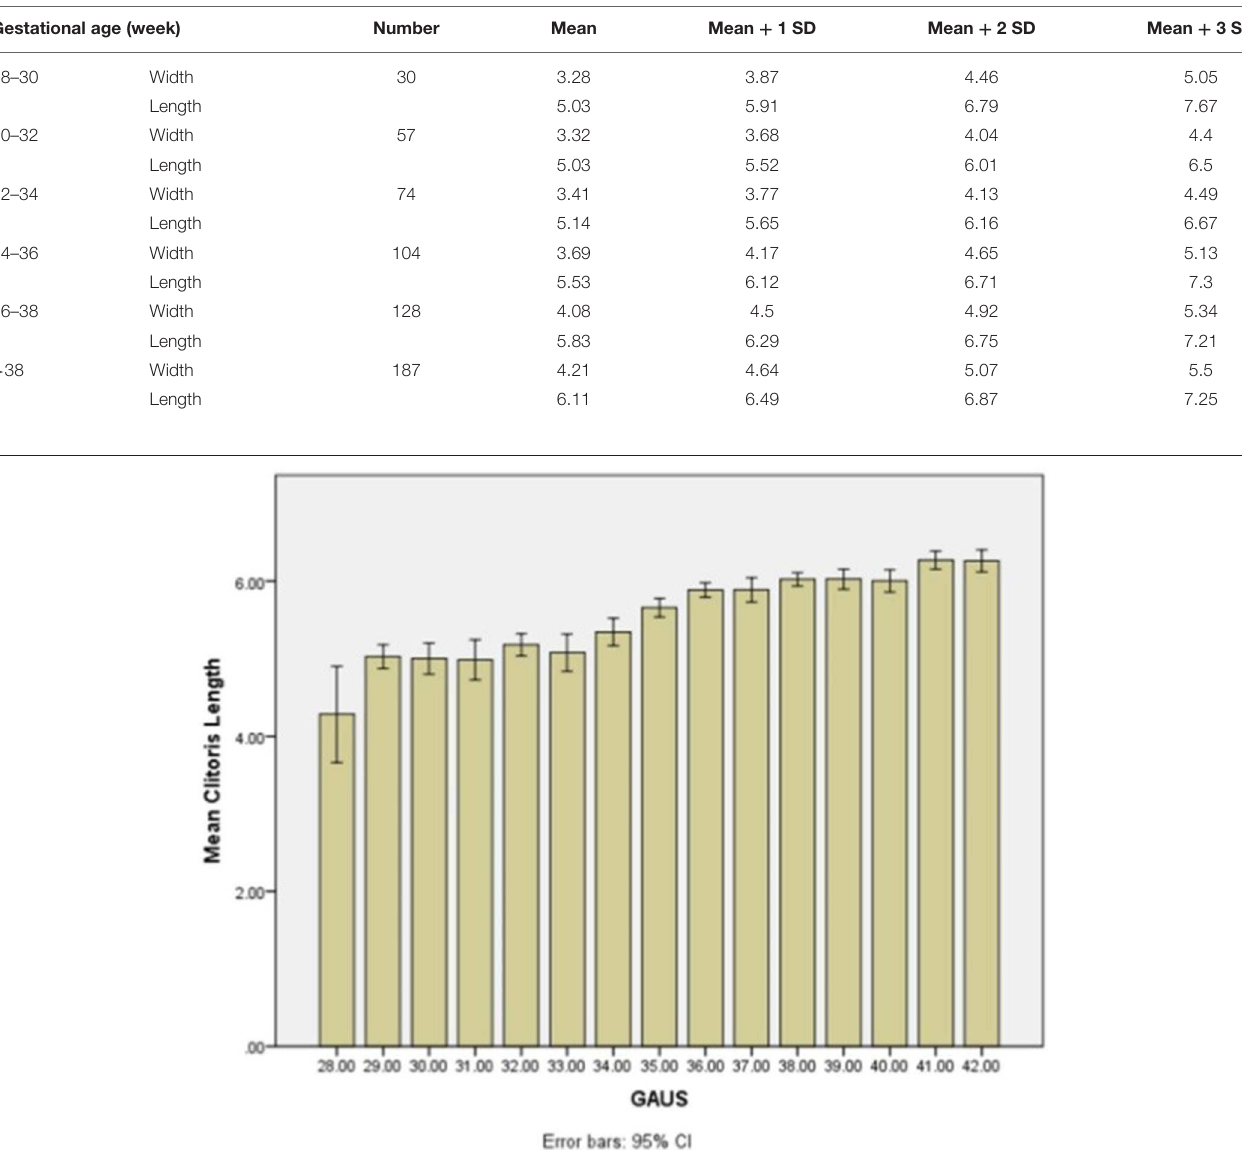
Mean ± SD values of CL were 6.11 ± 0.39 mm in term infants and 5.45 ± 0.64 mm in preterm infants ( P < 0.001). Mean ± SD values of CW were 4.22 ± 0.43 in term infants and 3.68 ± 0.53